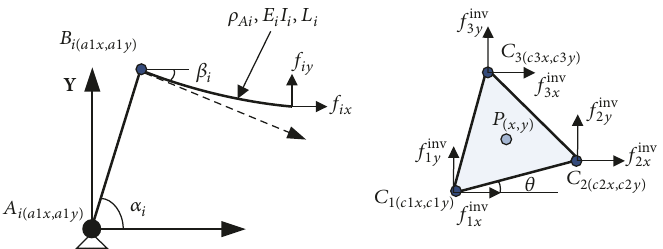
Figure 2: Schematic diagram of the 𝑖 th branch and moving